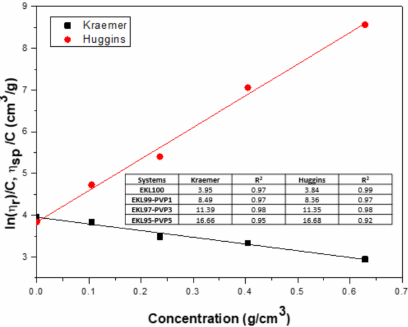
Figure 2. The Kraemer and Huggins plots for EKL/PVP solutions at a selected EKL:PVP ratio (100:0). The inset displayed the values of the intrinsic viscosity values for all the EKL:PVP ratios studied.